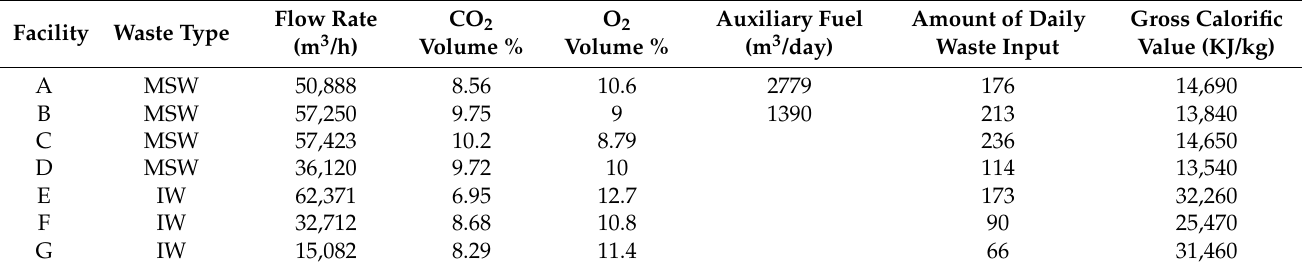
Table 6. Characteristics of real incineration facilities (adapted from [23]).